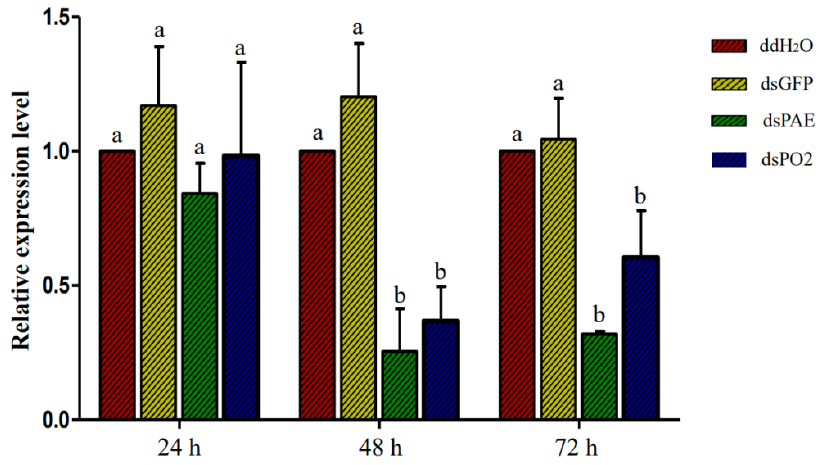
Figure 3. The relative mRNA transcript levels of S. frugiperda larvae after injecting with ddH 2 O, dsGFP, dsPAE and dsPO2 for 24, 48 and 72 h. Bars with the same letter are not significant, and different letters indicate a significant difference from each other at p < 0.05 based on Tukey’s test.